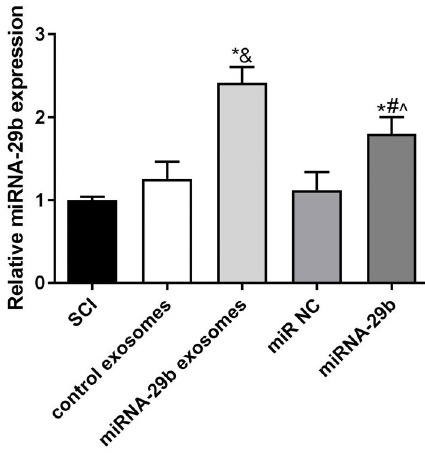
Figure 2. MiRNA-29b expression in spinal cord tissues of spinal cord injury (SCI) rats. Data are reported as means ± SD. *P o 0.05 vs SCI group; & P o 0.05 vs control exosomes; # P o 0.05 vs miR NC; ̂ P o 0.05 vs miRNA-29b exosomes (ANOVA).